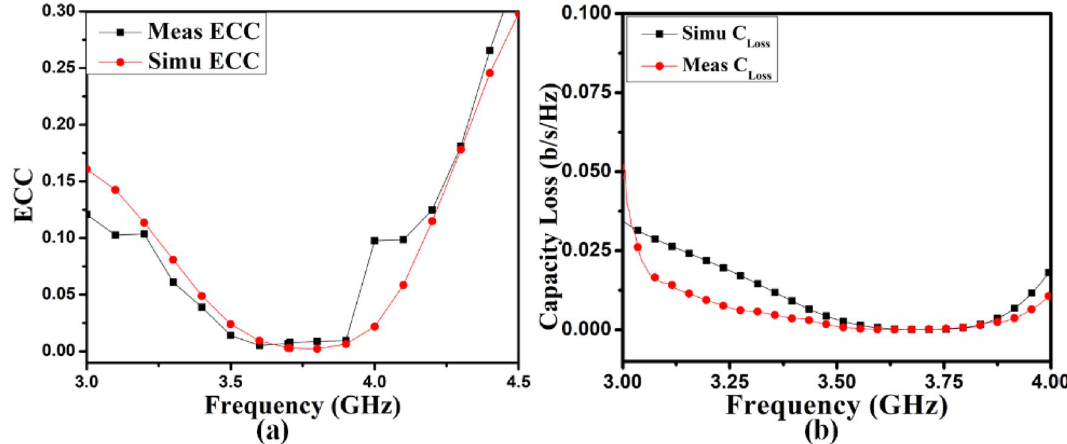
Figure 19. ( a ) ECC and ( b ) C loss results of proposed 2-Members MIMO (M-shaped)